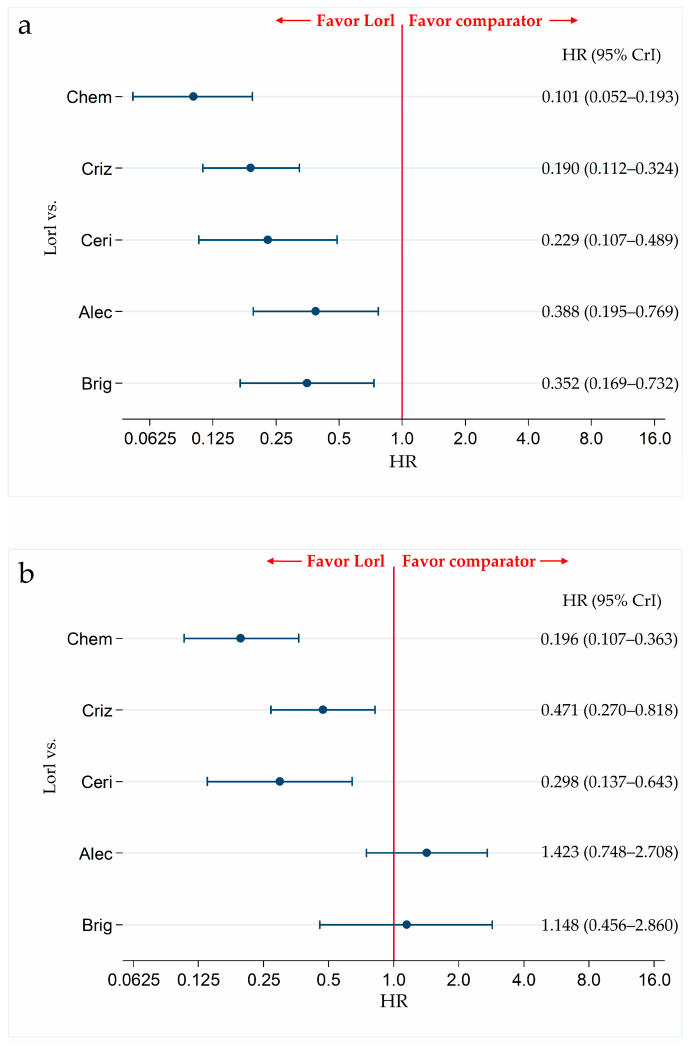
Figure 5. Comparative efficacy of lorlatinib and existing therapeutics in terms of PFS with in non- Asian and Asian patients with ALK-p ALK-inhibitor-naïve advanced NSCLC. A comparison between lorlatinib and each of the other five therapeutic agents, including chemotherapy, crizotinib, ceritinib, alectinib, and brigatinib as comparator in terms of PFS in patients with ALK-p ALK-inhibitor-naïve advanced NSCLC is presented. Comparisons are expressed as lorlatinib versus each of the comparator agents. Data are expressed as hazard ratios (HRs) and 95% credible intervals (CrIs); ( a ) Comparison in the non-Asian subgroup; ( b ) Comparison in the Asian subgroup. PFS, progression free survival; ALK, Anaplastic Lymphoma Kinase; ALK-p, Anaplastic Lymphoma Kinase-positive; NSCLC, non-small cell lung cancer; Lorl, lorlatinib; Brig, brigatinib; Alec, alectinib; Ceri, ceritinib; Criz, crizotinib; Chem, chemotherapy.